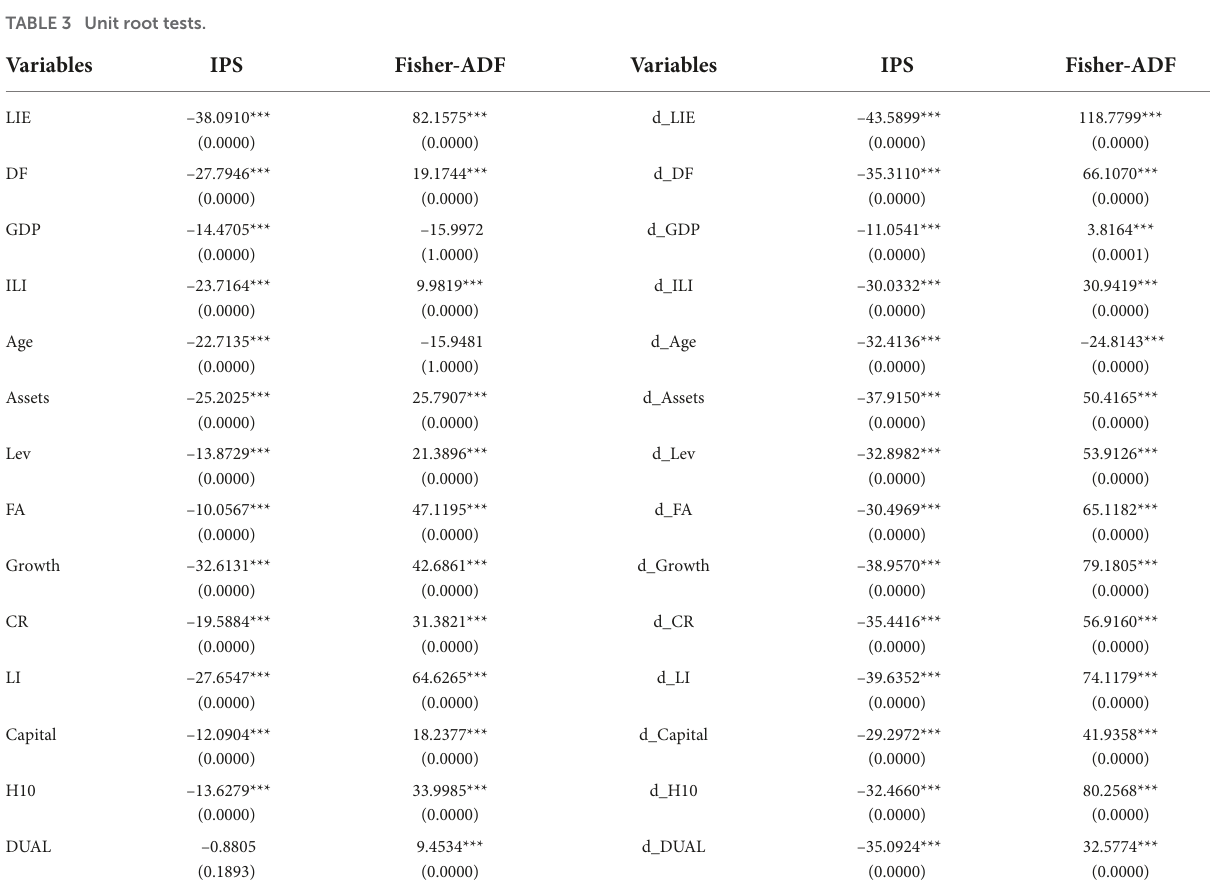
TABLE 3 Unit root